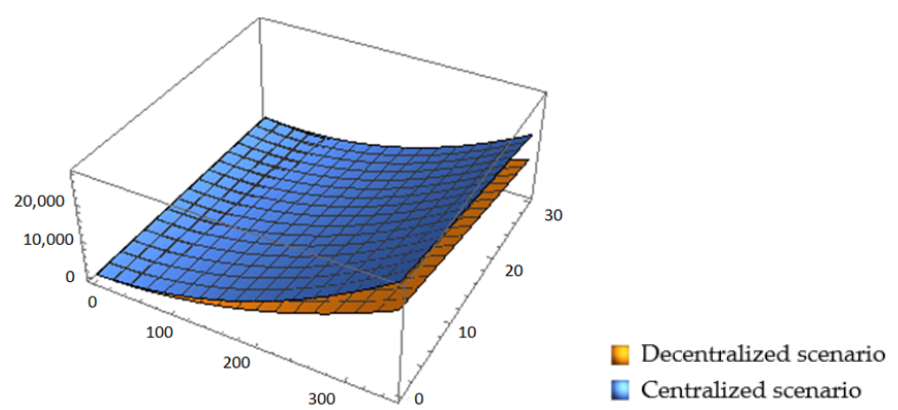
Figure 5. E ff ects of ε and q 0 on the total profits in CLSC. Figure 5. Effects of  and q 0 on the total profits in CLSC.